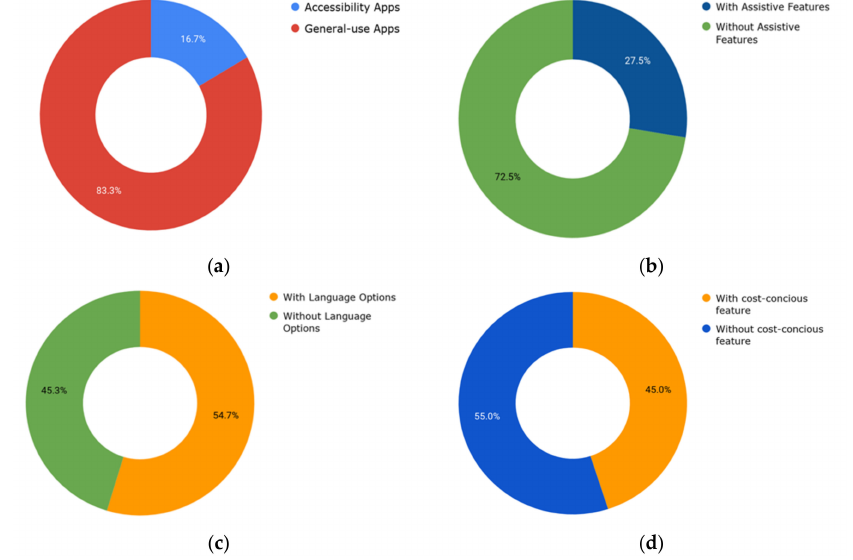
Figure 2. Findings from app analyses ( a ) Out of the 60 apps reviewed, 16.7% of them were accessibility apps and 83.3% were of general use ( b ) Percentage of general-use apps with and without assistive features ( c ) language options in all 60 apps ( d ) Apps with and without cost-conscious